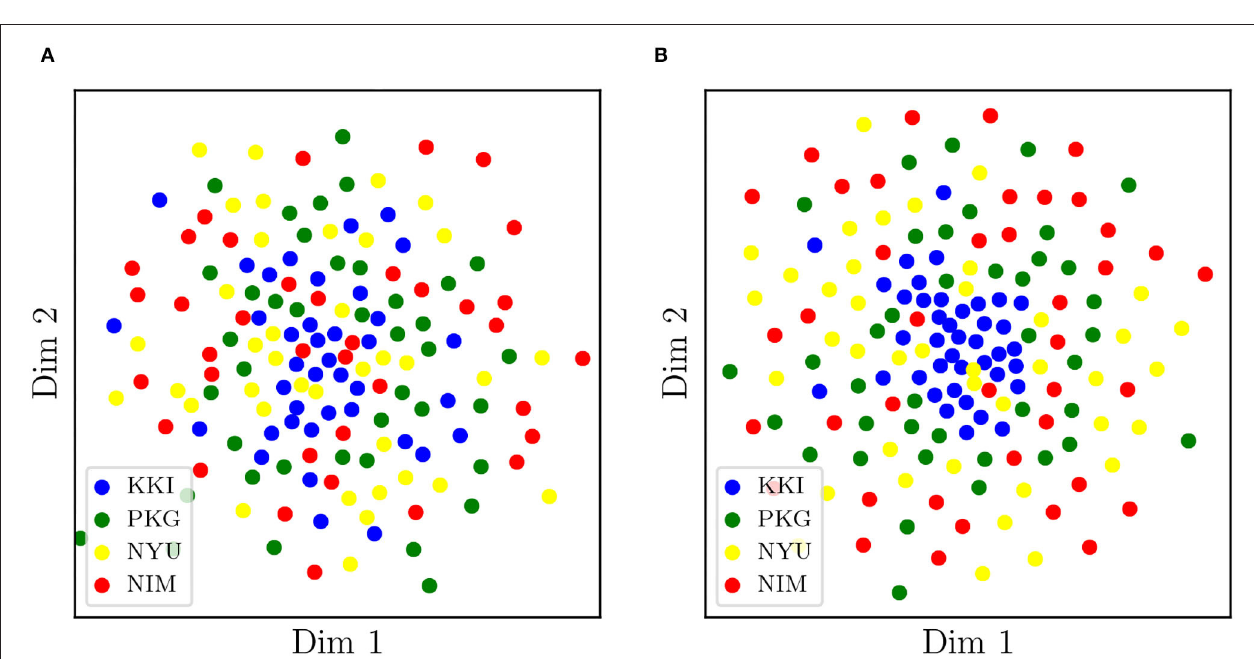
FIGURE 4 | (A) Two-dimensional embedding obtained after applying t-stochastic neighbor embedding to the logarithms of matrices transformed under matrix whitening. (B) Two-dimensional embedding obtained after applying t-stochastic neighbor embedding to the logarithms of matrices transformed under Rigid Log-Euclidean Translation to the global mean 6 . KKI, Kennedy Krieger Institute, Johns Hopkins University; NYU, New York University Child Study Center; PKG, Peking University; NIM, NeuroIMAGE sample.